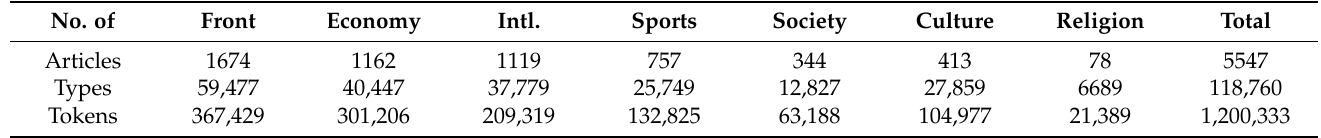
Table 2. Basic statistical information about the 2022 Saudi